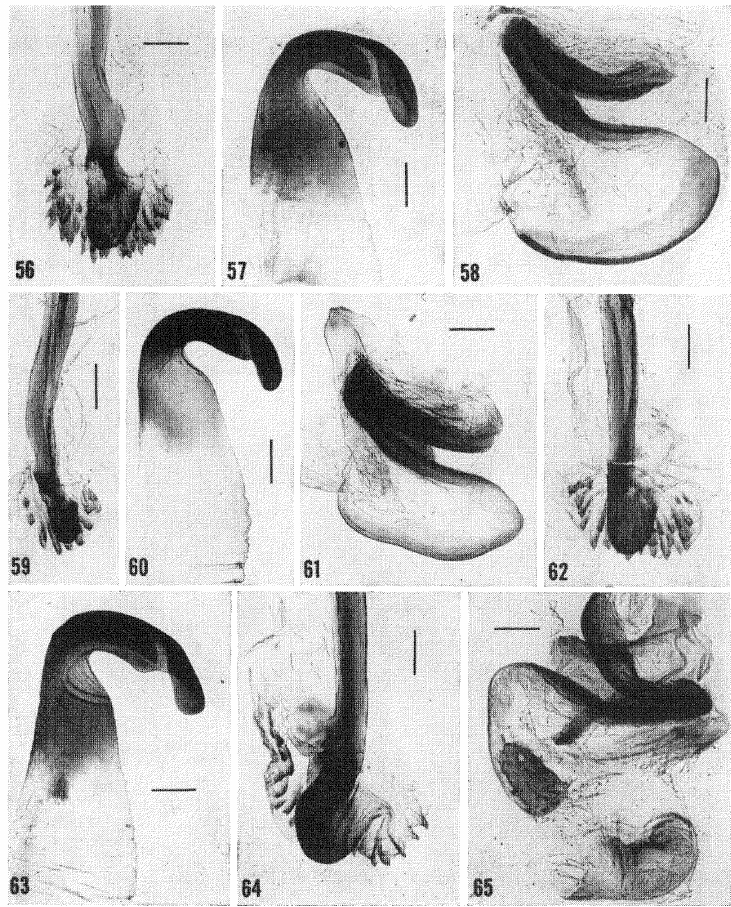
Figs. 56-65. 56-58. (22 ANSP). Blaptica obscura. (from specimen shown in Fig. 27). 59-61. (20 ANSP). Bl’aptica interior. (from specimen shown in Fig. 26). 62-63. (21 ANSP). BlaItica dubia. (from specimen shown in Fig. 29). 64-65. (6 ANSP). Styphon bakeri. (from specimen shown in Fig. 31). (Fig. 65 is a ventral view.) (scale-- 0.3